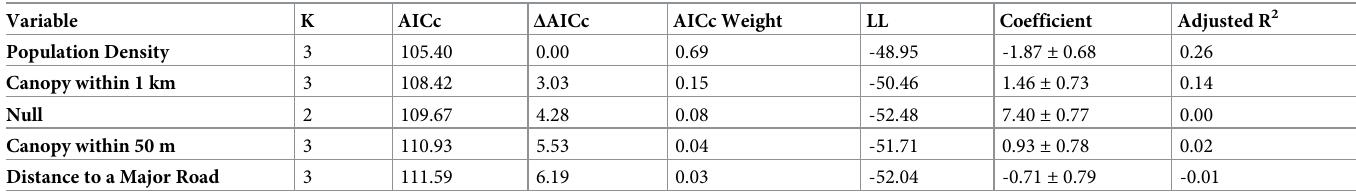
Table 3. AIC table for single explanatory variable linear models predicting aquatic bird species richness, compared with a null model.